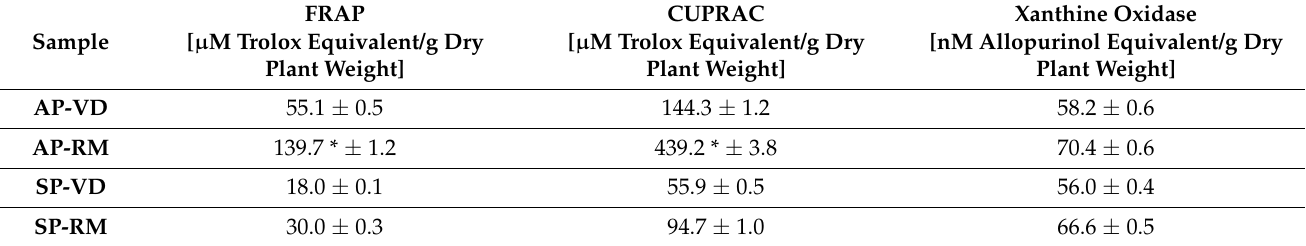
Table 3. Antioxidant capacity of aerial (AP) and subterranean parts (SP) of T. farfara hydro-ethanolic